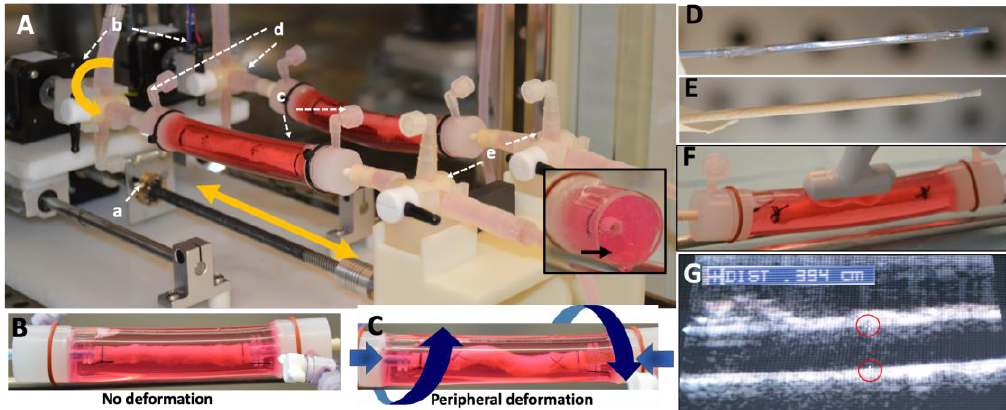
Figure 1. Schematic illustration of the novel peripheral simulating bioreactor system. ( A ) Two servos (a and b) provide axial deformation and twisting, respectively. Servo (a) moves the harvested arteries (c) forward and backward in a linear motion. Servo b rotates the artery by degrees. The three-way values (d and e) are used to introduce flow and pressure to the artery. The artery is surrounded by matrigel, mimicking external tissue, providing support during vascular movement (insert, black arrow). ( B and C ) Harvested arteries under pulsatile (no deformation) and pulsatile conditions with peripheral deformation. ( D and E ) Gross photos of an uncoated balloon and a keratose – paclitaxel coated balloon. ( F and G ) Diameter measurements performed by ultrasound on the harvested artery.